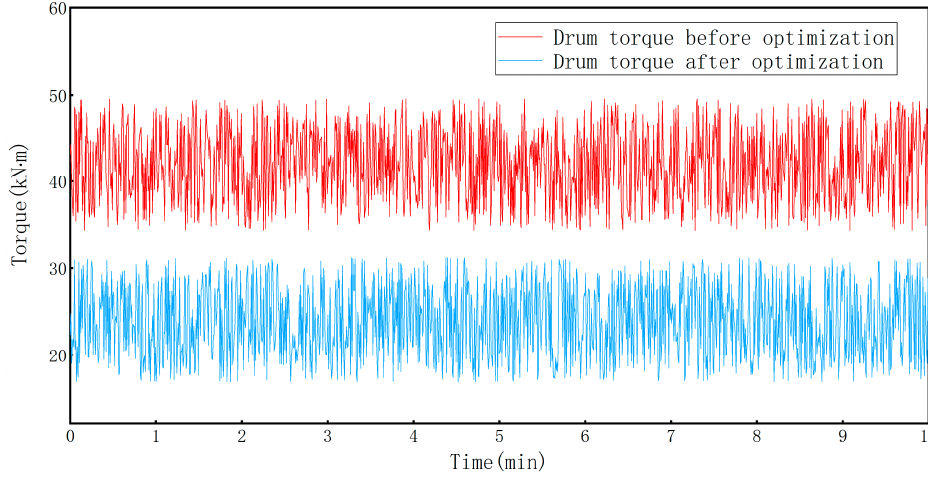
Figure 8. The drum torque during test.